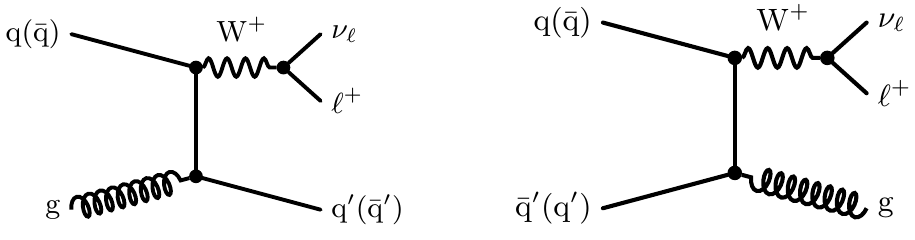
Figure 1 . Leading-order Feynman diagrams of the hadronic process pp → ‘ + ν ‘